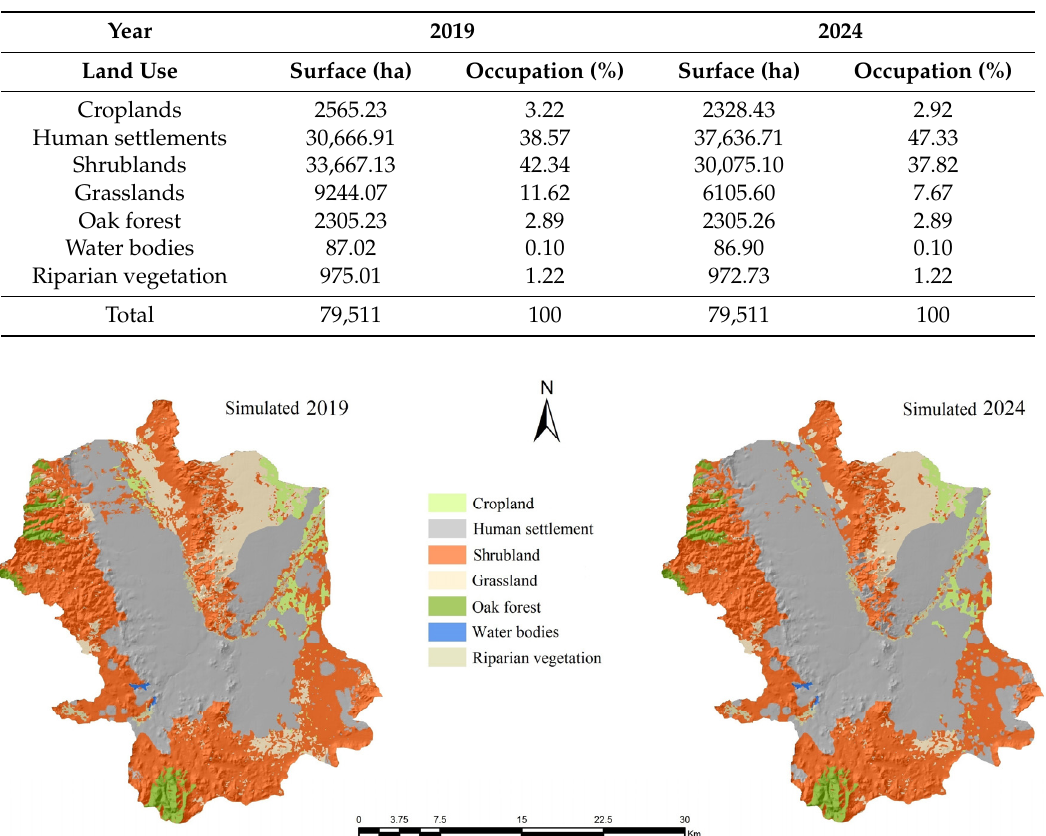
Table 9. Simulated coverage areas and percentage of occupation of seven land uses of the urban and peripheral areas of Chihuahua City by 2019 and 2024.